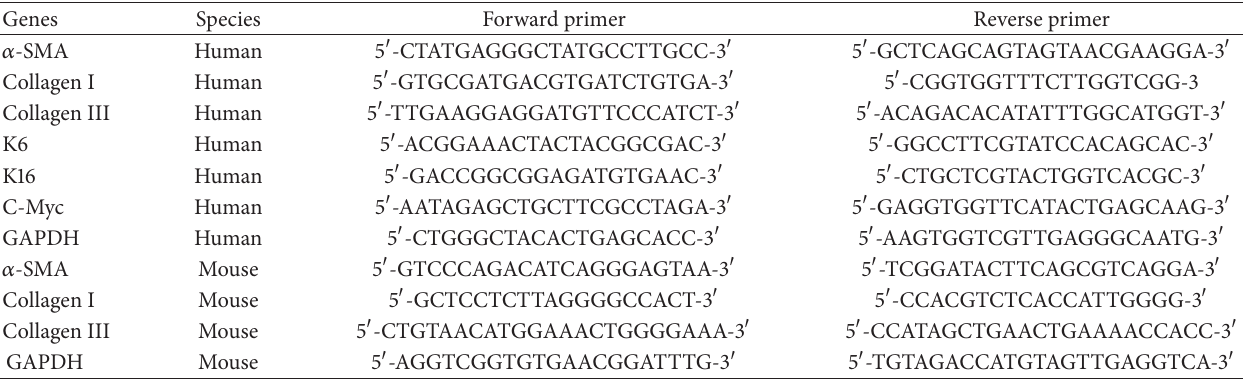
Table 1: List of sequences of forward and reverse